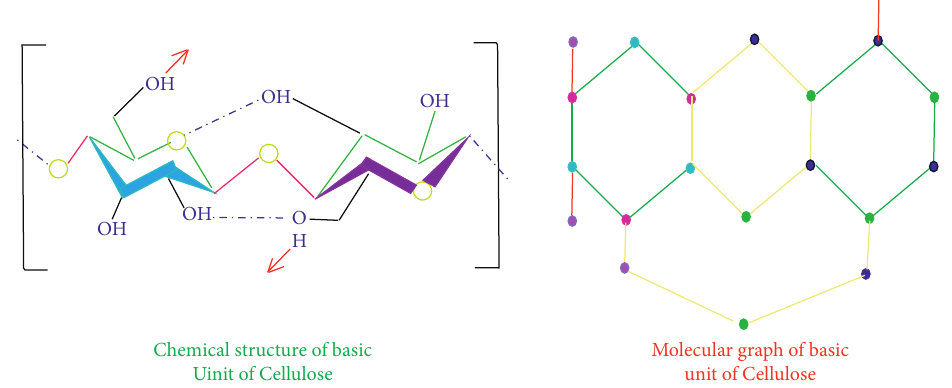
Figure 3: 2D skeleton of basic units of cellulose.